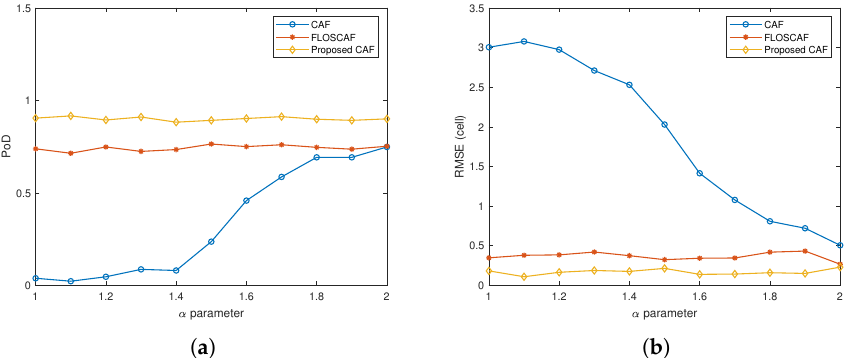
Figure 9. ( a ) PoD comparison for different algorithms (RCS = 1 m 2 ) ( b ) RMSE comparison for different algorithms (RCS = 1 m 2 ).